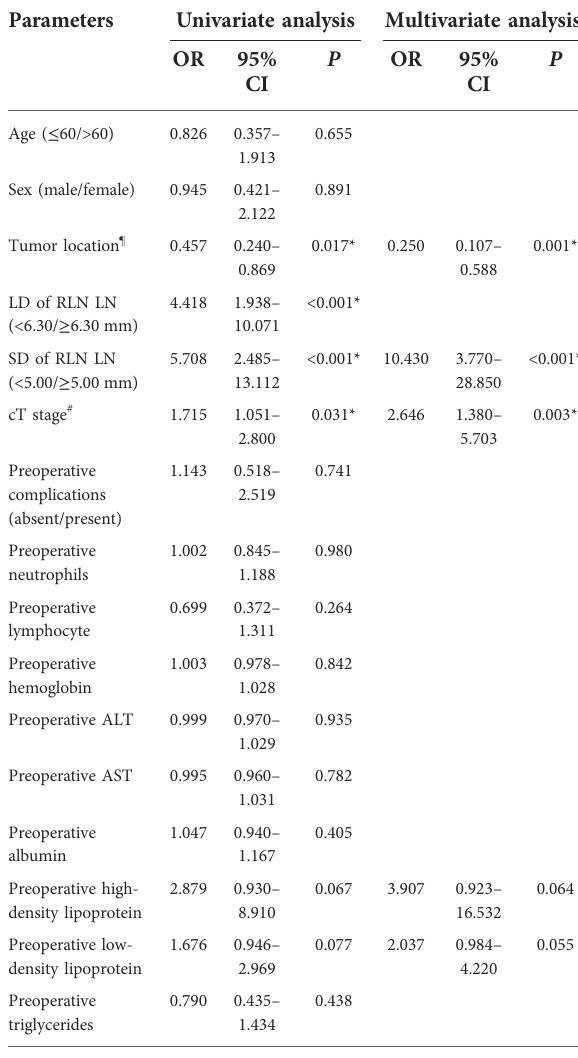
TABLE 3 Univariate and multivariate analyses for risk factors of right RLN